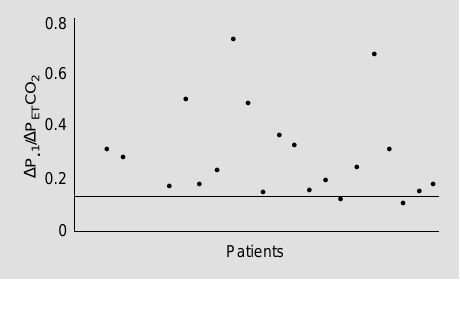
Figure 2 - Individual values of D VE/ D P ET CO 2 in normocapnic patients with OSA. The horizon- tal line corresponds to the lower limit of normality at 1.16 l min -1 mmHg -1